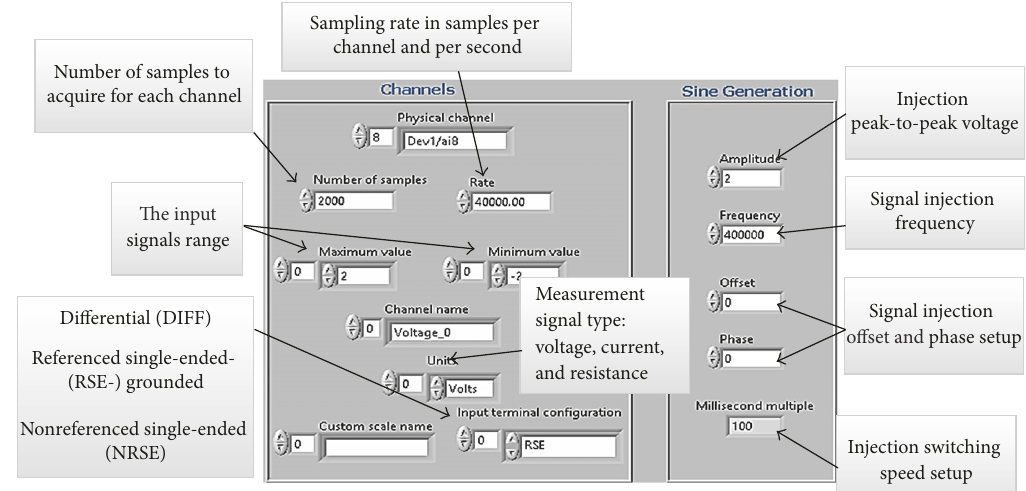
Figure 6: Channel configuration and signal generator configuration controls.